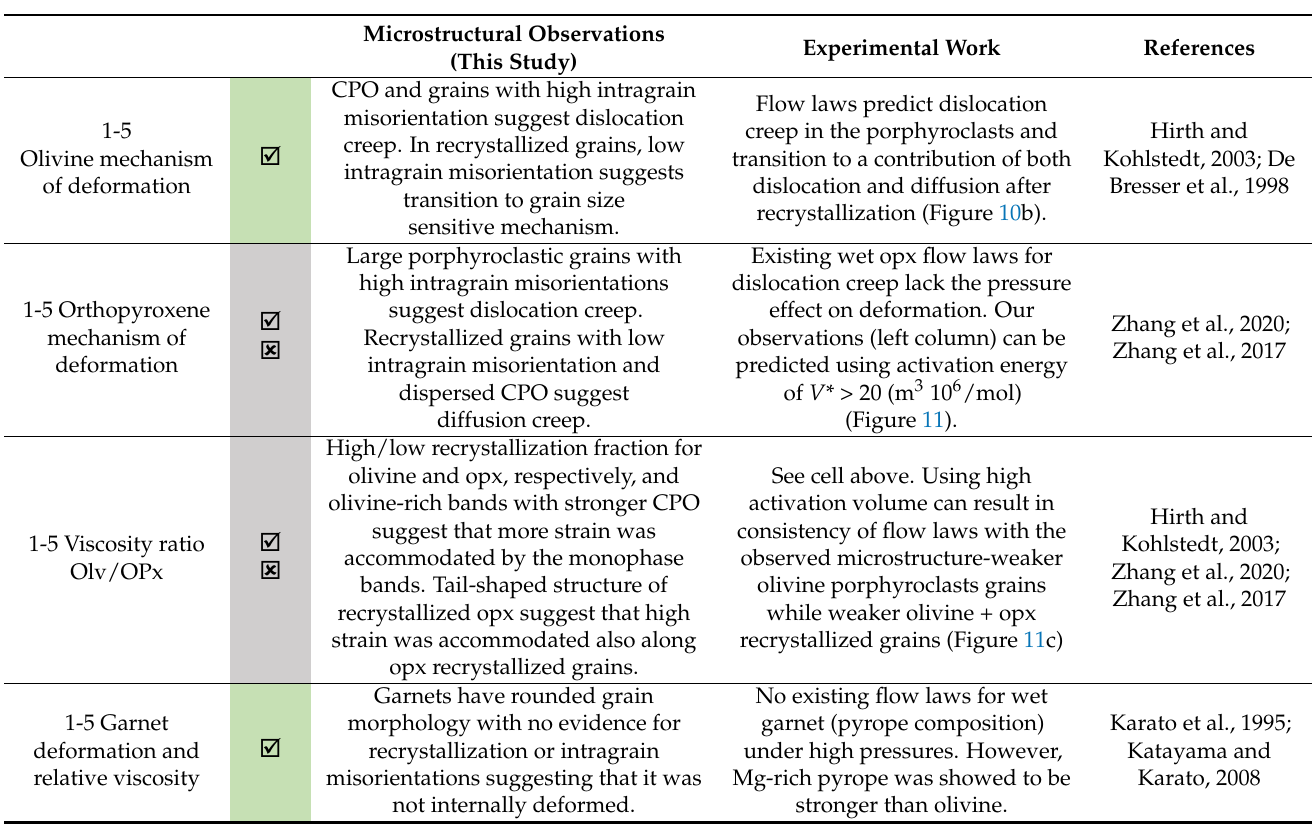
creep, consistent with their microstructures. To illustrate consistency between microstruc- tural observations and flow laws, the activation volume for dislocation creep of wet opx [78] needs to be greater than ~20 m 3 10 6